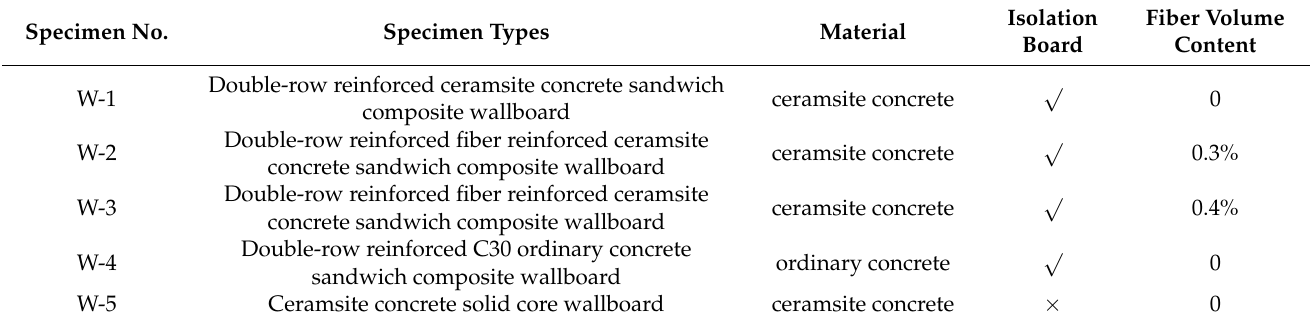
Table 1. Parameters of the specimens.